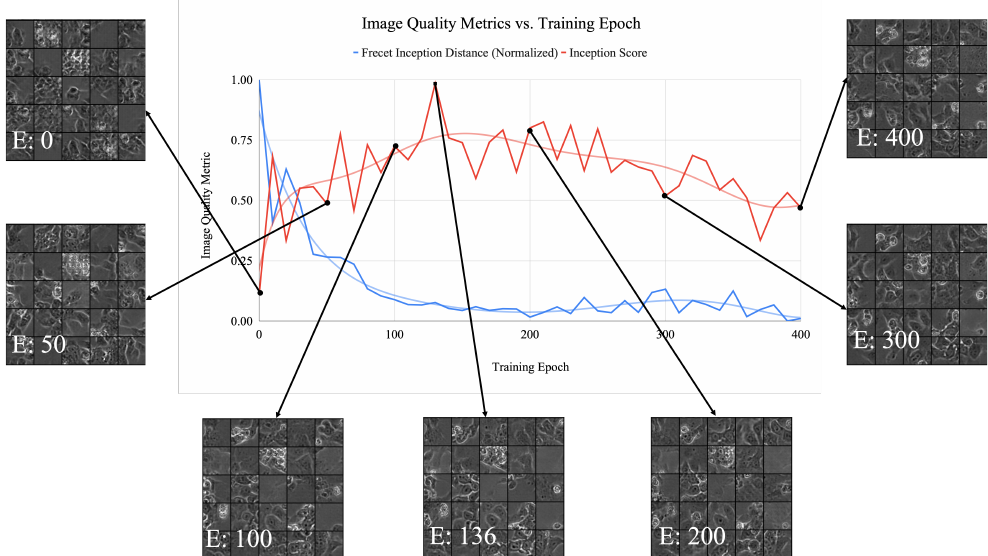
Figure 7. Normalized generator inception score (red) and FID (blue) per training epoch with ex- ample images at various intervals for the spread class. Graphs include accompanying trend line. Training epoch numbers are marked by a white ’E’ in the bottom of each image. Agreement between inception score and FID can be seen in terms of their relative minimum and maximum values versus training